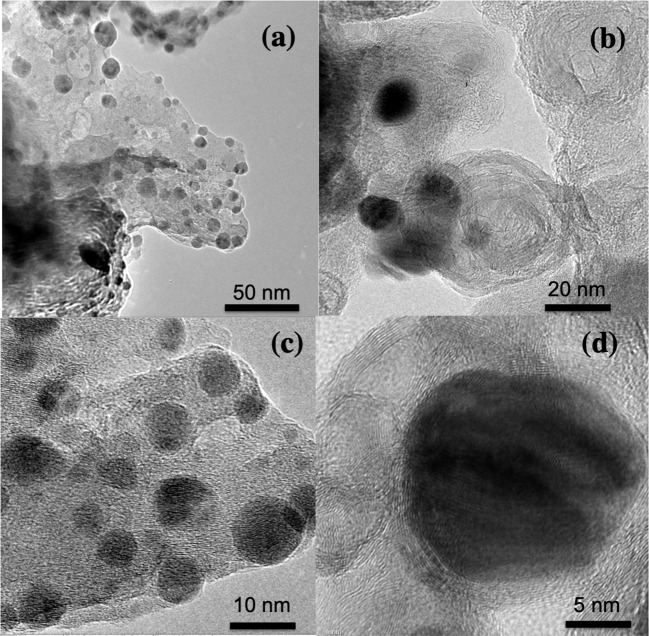
(a-d) TEM images of Mn2O3/NC-500-20 at different resolutions.